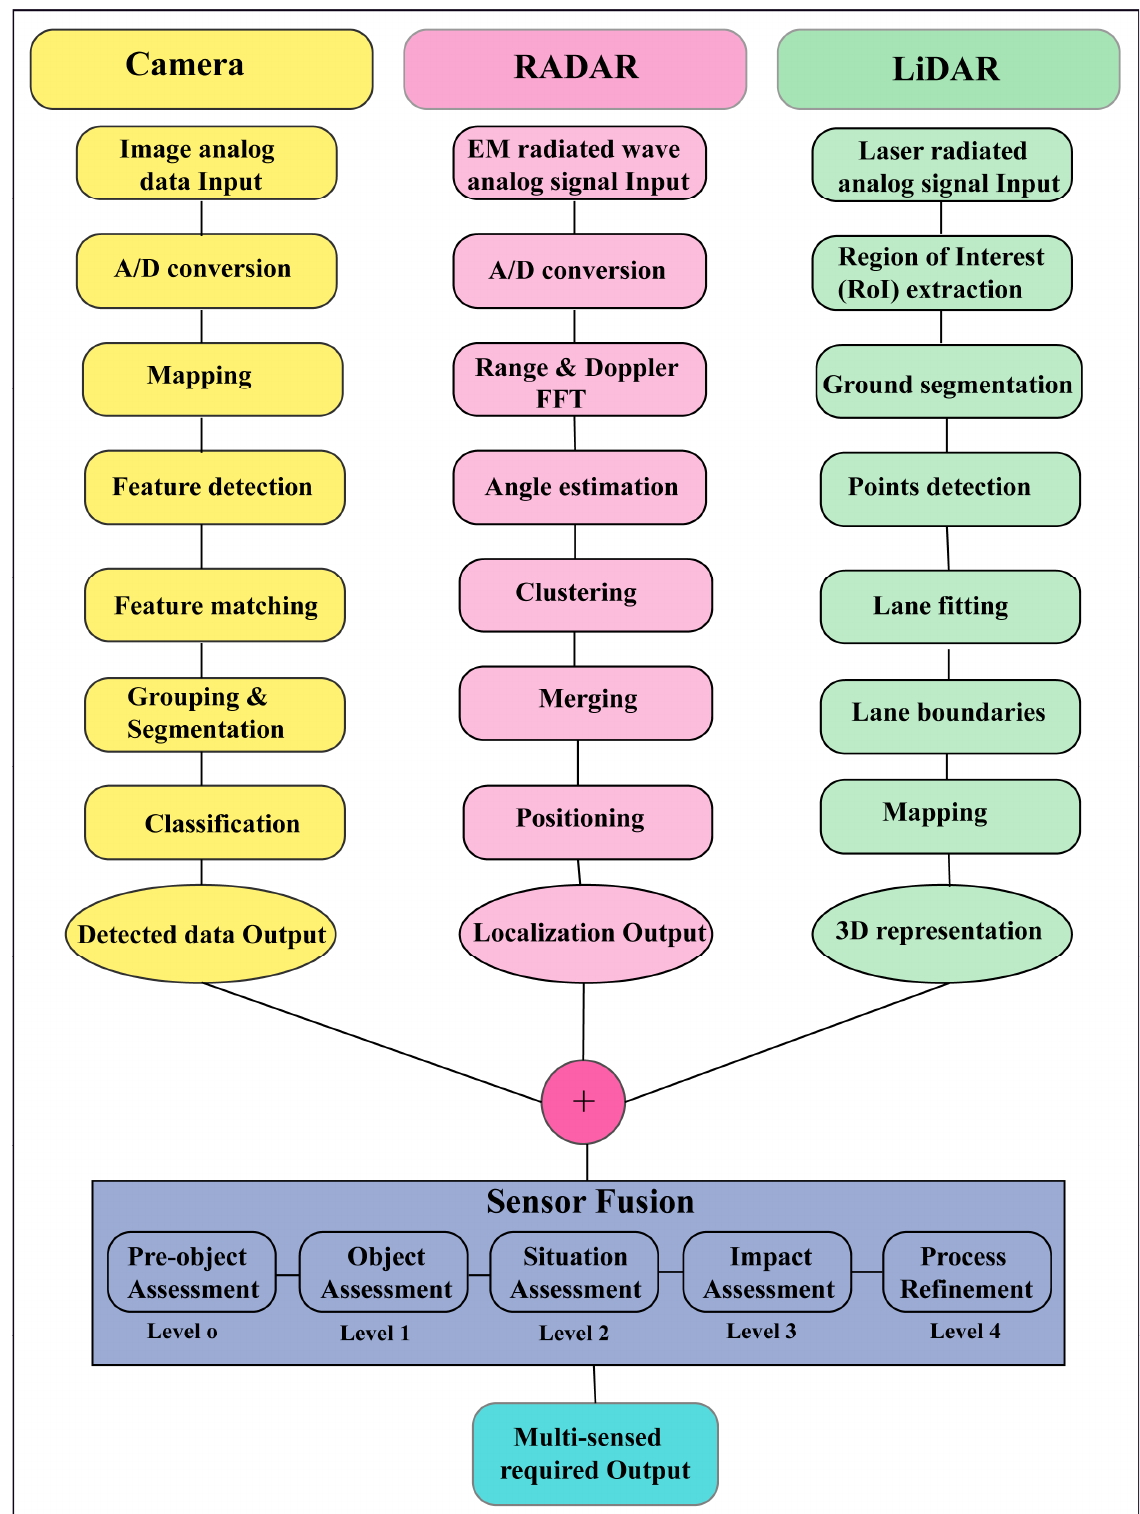
Figure 6. The summarized fl ow chart of sensor fusion technologies in AVs.